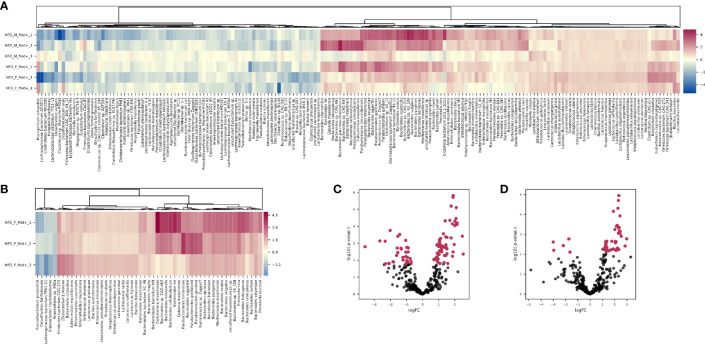
Differentially abundant species. (A) Heatmap showing differentially abundant species in HFD_Met+ groups before and after metformin treatment. (B) Heatmap showing differentially abundant species in HFD_F_Met+ group before and after metformin treatment. (C) Volcano plot showing P-values of differentially abundant species in HFD Met+ groups before and after metformin treatment. (D) Volcano plot showing P-values of differentially abundant species in HFD F_Met+ group before and after metformin treatment. Red dots represent differentially abundant species with P-values < 0.05.